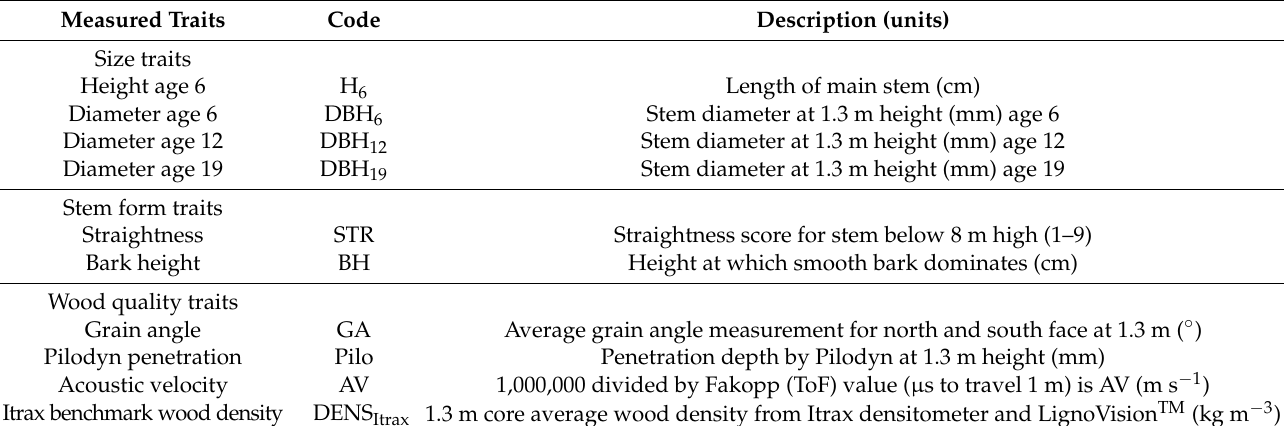
Table 1. Measurements and units for manual, visual and non-destructive field